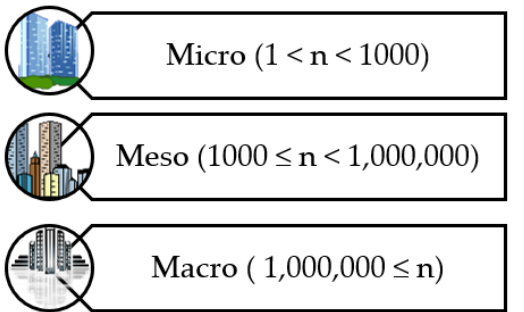
Figure 3. Physics-based urban building energy modeling project definition, data, and metadata extraction approach and categories.